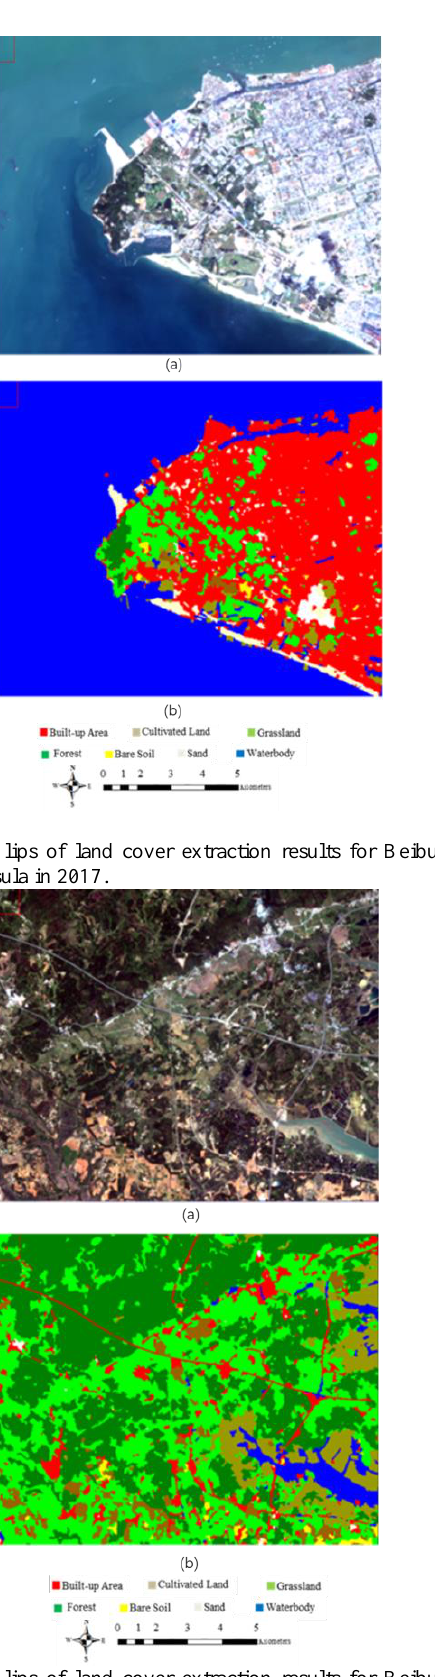
Figure 6. Clips of land cover extraction results for Beibuwan Gulf inner area in 2017.